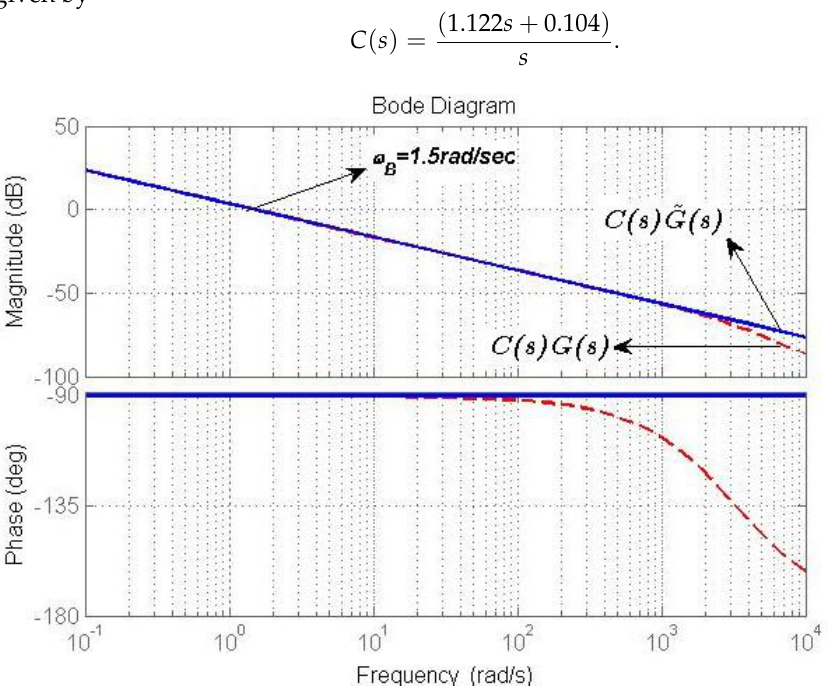
Figure 14. Open loop Bode diagrams of C ( s ) ˜ G ( s ) and C ( s ) G ( s )